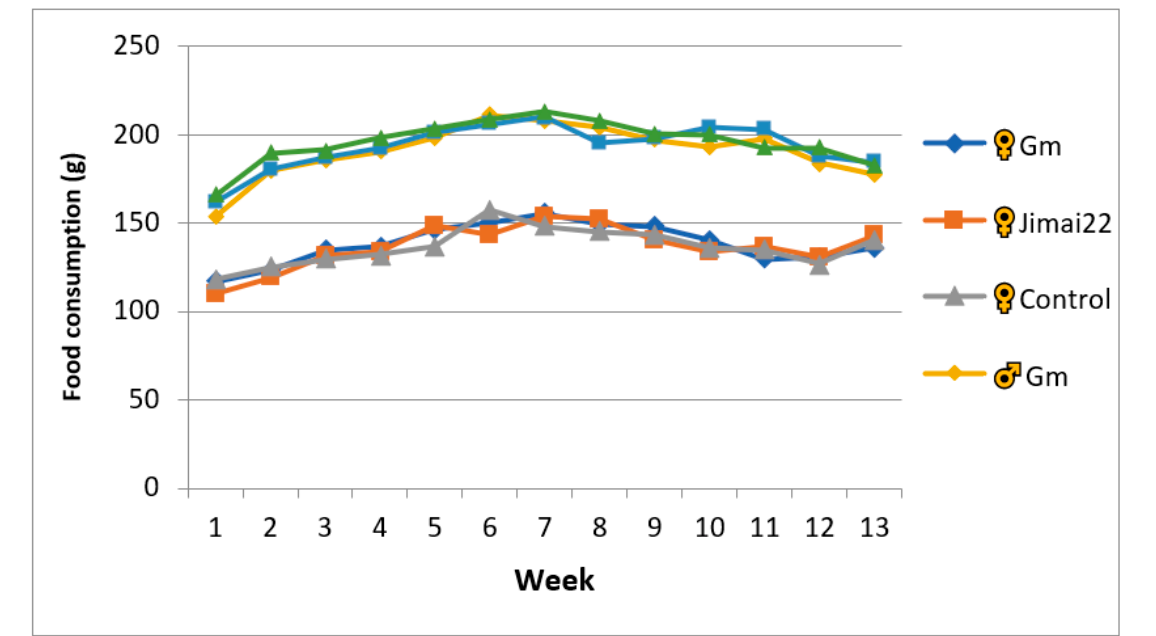
Figure 2. Weekly food consumption of female and male animals in three groups. There were no significant differences between the Gm group and Jimai22 group ( p > 0.05) in total body weight gains, total food consumption or total food utilization rate. Compared with the AIN-93 control group, the total body weight gains and total food utilization of the Gm group (females and males) were both significantly higher ( p < 0.01, p < 0.01), but total food intake of Gm females and Gm males displayed no difference ( p > 0.05). The results are shown in Figures 3–5.